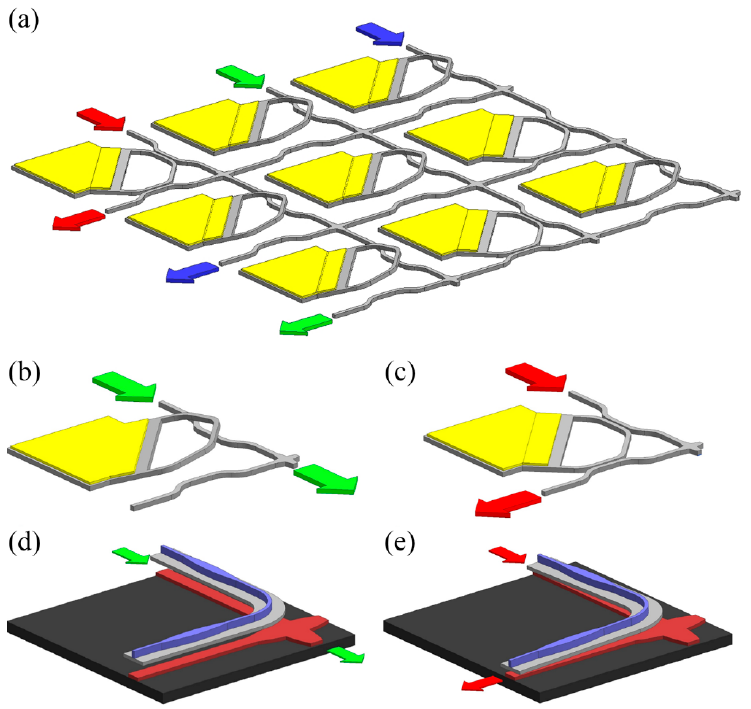
Figure 4. ( a ) Schematic of a large scale switch based on variable coupled waveguides. The yellow structures denote deposited gold layers. ( b , c ) Illustration of the through and drop states of a unit cell. ( d , e ) Illustration of the through and drop states of a unit cell of an improved design, in which the blue and red structures denote the suspended rib waveguide and the fixed rib waveguide, respectively.